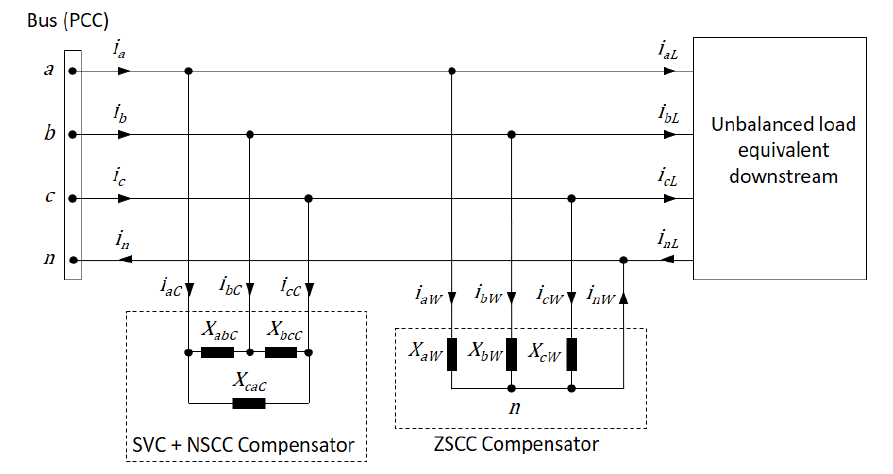
Figure 7. Unified proposal with compensator “SVC + NSCC” connected in delta. SVC = positive-sequence reactive component; NSCC = negative-sequence currents.